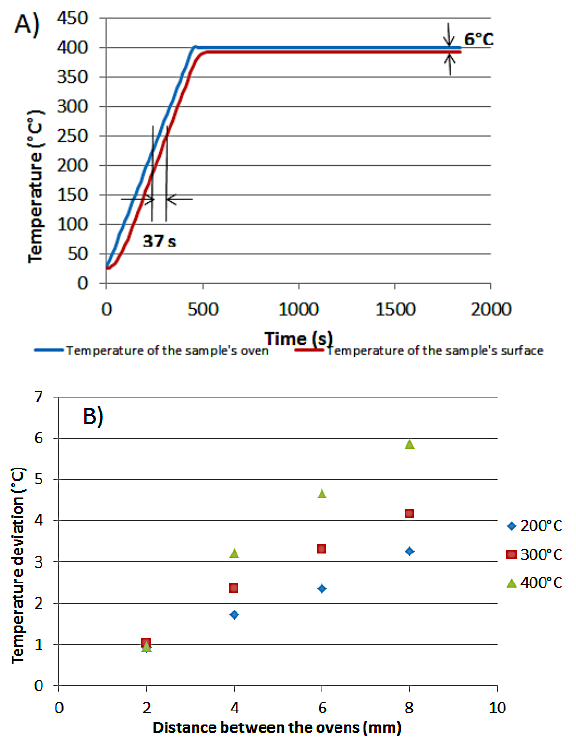
Figure 4. (a) Temperature difference between the thermocouple of regulation of the oven and the tem- perature of the sample (b) Temperature deviation as function of the distance between the two